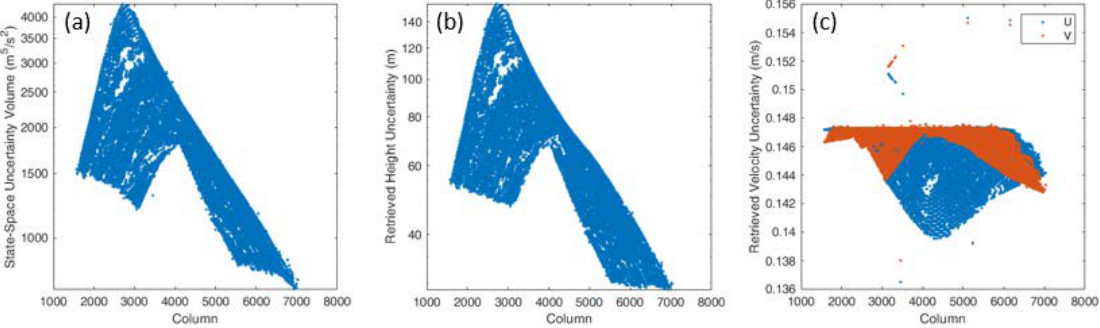
Figure 10. The state-space uncertainty volume ( a ) and state standard errors ( b , c ) are estimated from the covariance matrix from the retrieval performed at each site. The case shown is MODIS granule MOD2018196.1700.061 (MODIS Band 1) paired with GOES-16 CONUS ABI Band 2. Some out-of-family covariances are calculated when the retrieved parallax corrections to site locations place a retrieved site at an inappropriate location. These retrievals are generally filtered out in later quality screening.